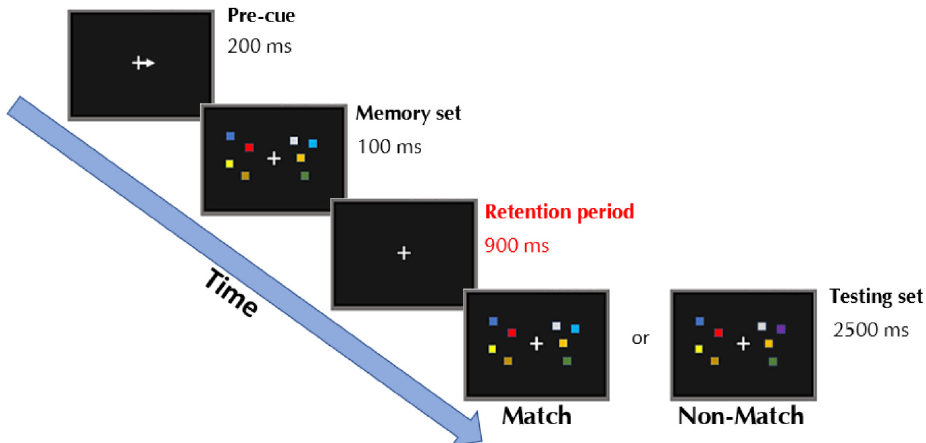
Figure 2. Schematic representation of the working memory (WM) change-discrimination task em- ployed during each experimental trial.